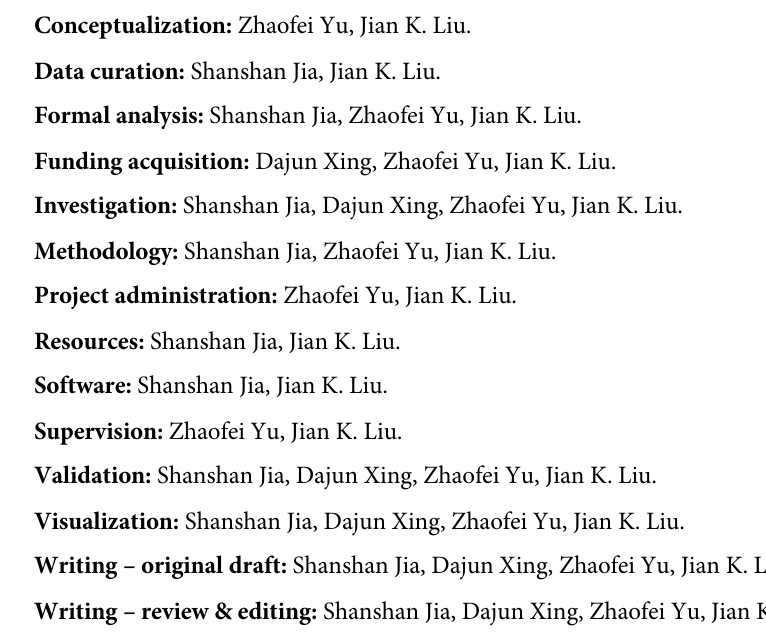
S2 Fig. Related to Fig 3. STNMF is able to infer more cells across layers in a network. The three-layer network has 16 cells in Layer 1. Among them, neurons 1–8 are connected to the first neuron of Layer 2, and neurons 9–16 are connected to the second neuron of Layer 2. The STA shows the receptive field of the Layer 3 cell. The receptive fields of modeled Layer 1 cells are recovered by the STNMF inference. S3 Fig. Related to Fig 3. STNMF enables to infer presynaptic cells with overlapped recep- tive fields. There are four Layer 1 cells with overlapped receptive fields. The STA shows the overall receptive field of the Layer 3 cell, while the STNMF separates them into individual ones of Layer 1 cells. S4 Fig. Related to Fig 3. STNMF inference in a four-layer network. Similar to Fig 3 but with a four-layer structure. The STA shows the receptive field of the Layer 4 cell, while the STNMF obtains the receptive fields of Layer 1 cells. S5 Fig. Related to Fig 3. STNMF is able to infer cells in the network with weak recurrence. Similar to Fig 3 but with a recurrent connection from the Layer 3 cell to cell 2 in Layer 2. The recurrent connection weight is 0.1, compared to other weights as 1. STNMF can infer the receptive fields of Layer 1 cells. S6 Fig. Related to Fig 3. STNMF is able to infer cells in the network with weak feedback. Similar to Fig 3 but with a feedback connection from the Layer 3 cell to cell 1 in Layer 2. The feedback connection weight is 0.1, compared to other weights as 1. STNMF can infer the receptive fields of Layer 1